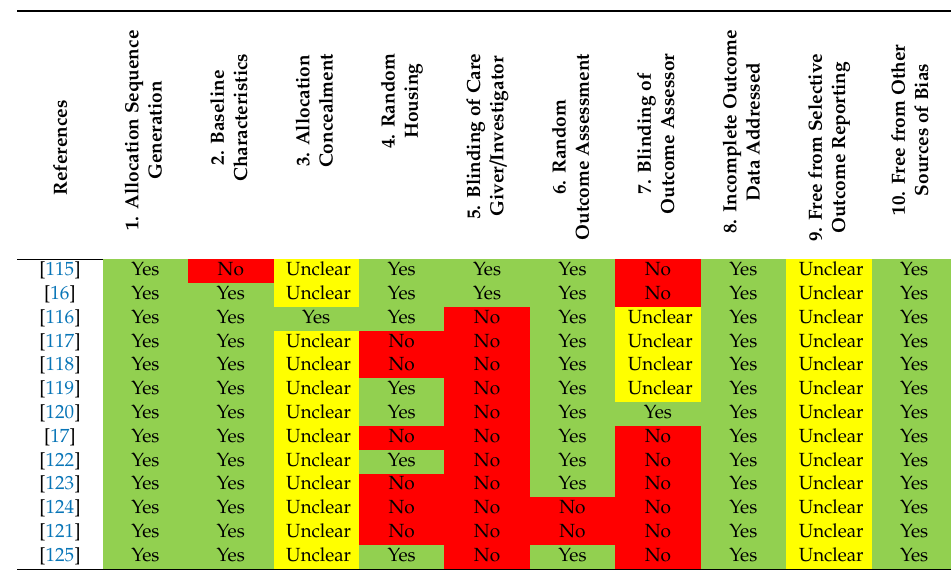
Table 8. Risk of bias